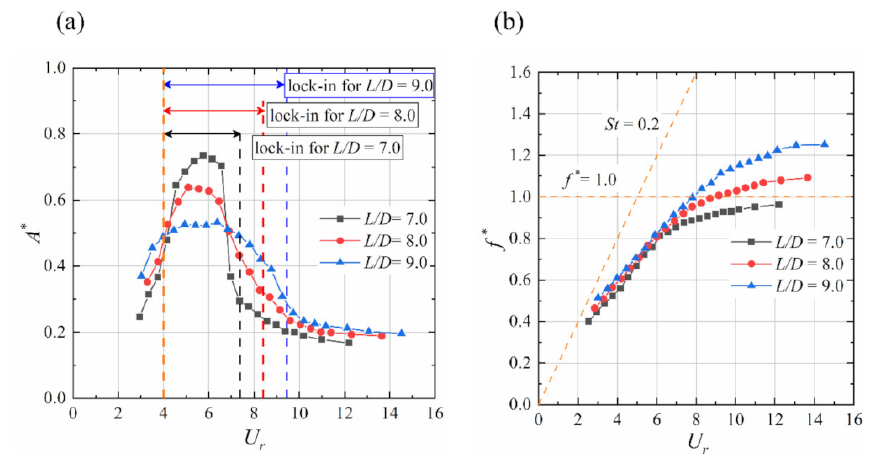
Figure 18. Complete rotation response of FIR system at L / D = 7.0, 8.0 and 9.0: ( a ) Arc length response; ( b ) Frequency